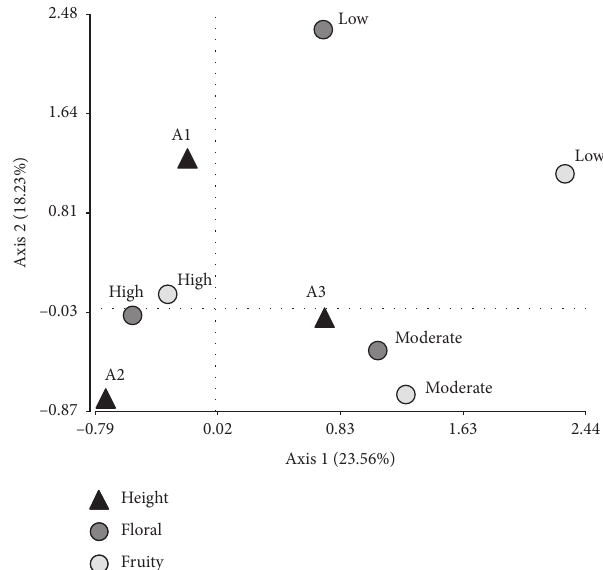
Figure 10: Multiple correspondence analysis for sampling altitude (A1: less than 500m.a.s.l; A2: from 501 to 800m.a.s.l; A3: